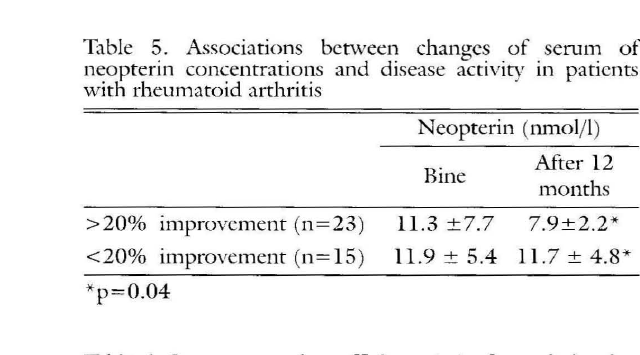
Table 5. Associations between changes of serum of neopterin concentrations and disease activity in patients with rheumatoid arthritis